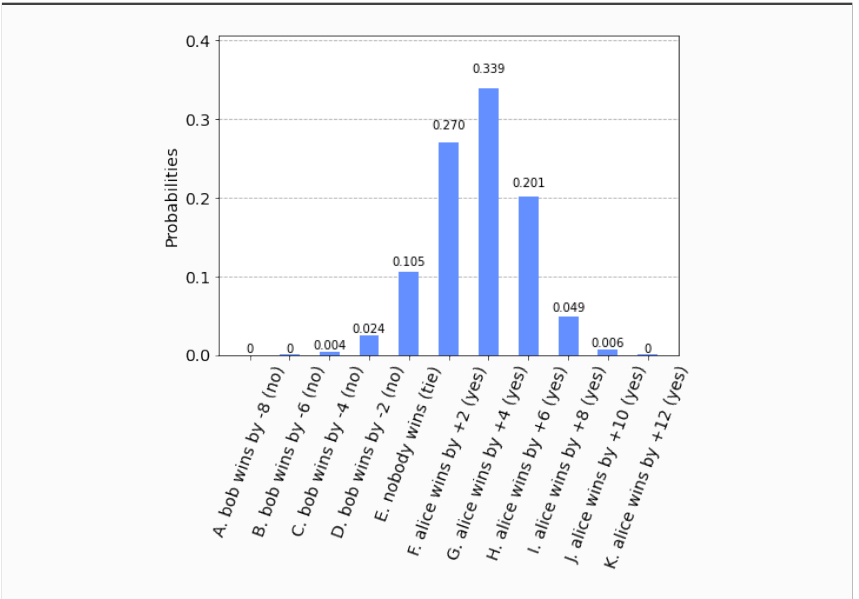
Figure 21. The possible outcomes and their probabilities with 2 independent legislators and r A = r B = 0.5.